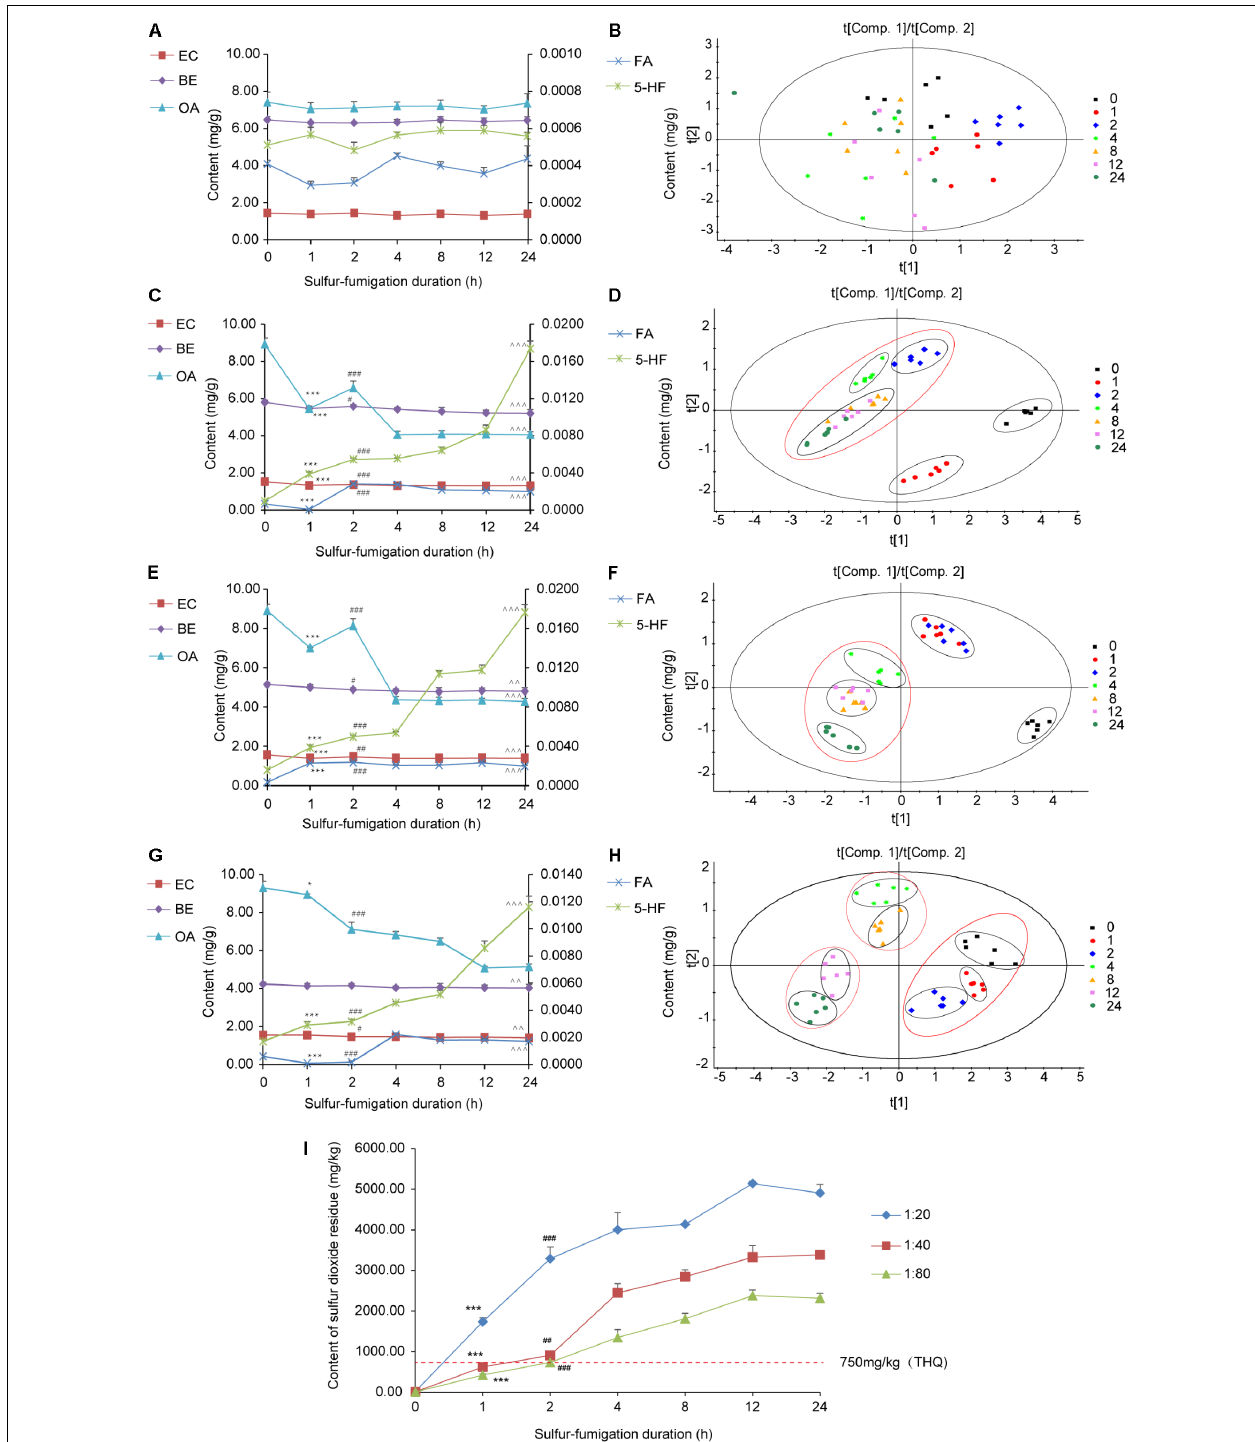
FIGURE 5 | Content variations and PLS-DA coefficient plot of the five major compounds and sulfur dioxide residue in the AB sample within 24 h sulfur-fumigation. (A) Non-fumigated sample; (B) non-fumigated sample (PLS-DA); (C) the weight ratio of sulfur to AB (1:20); (D) the weight ratio of sulfur to GR (1:20) (PLS-DA); (E) the weight ratio of sulfur to AB (1:40); (F) the weight ratio of sulfur to GR (1:40) (PLS-DA); (G) the weight ratio of sulfur to AB (1:80); (H) the weight ratio of sulfur to GR (1:80) (PLS-DA). ( ∗∗∗ p < 0.001, ∗ p < 0.05, compared with the 0 h; ### p < 0.001, ## p < 0.01, # p < 0.05, compared with the 0 h; ˆˆˆ p < 0.001, ˆˆ p < 0.001, compared with the 0 h) (I) content variations of sulfur dioxide residue in sulfur-fumigation process ( ∗∗∗ p < 0.001, compared with 0 h; ### p < 0.001, ## p < 0.01 compared with 1 h). All samples include three biological replicates, and two replicates parallel to each biology.